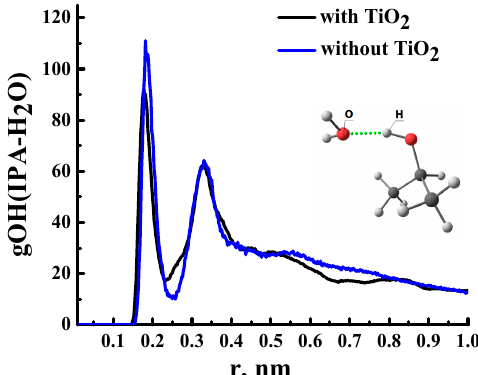
Figure 13. Pair radial distribution function for O and H atoms of IPA and H 2 O molecules, respectively.